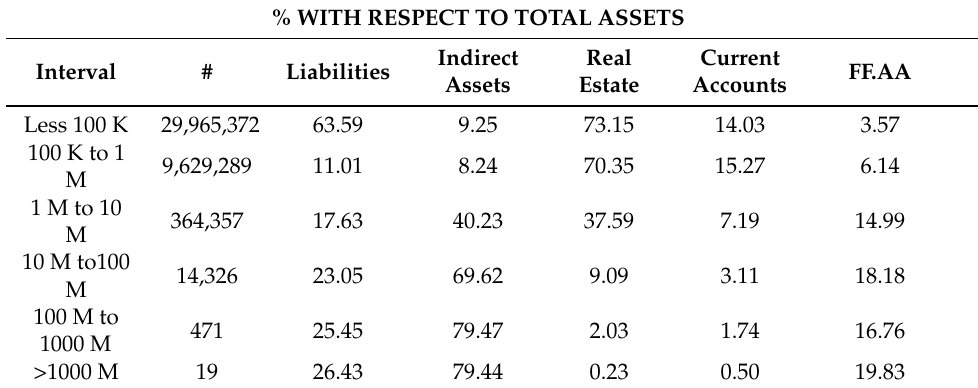
Table 4. Distribution of net worth and its components by